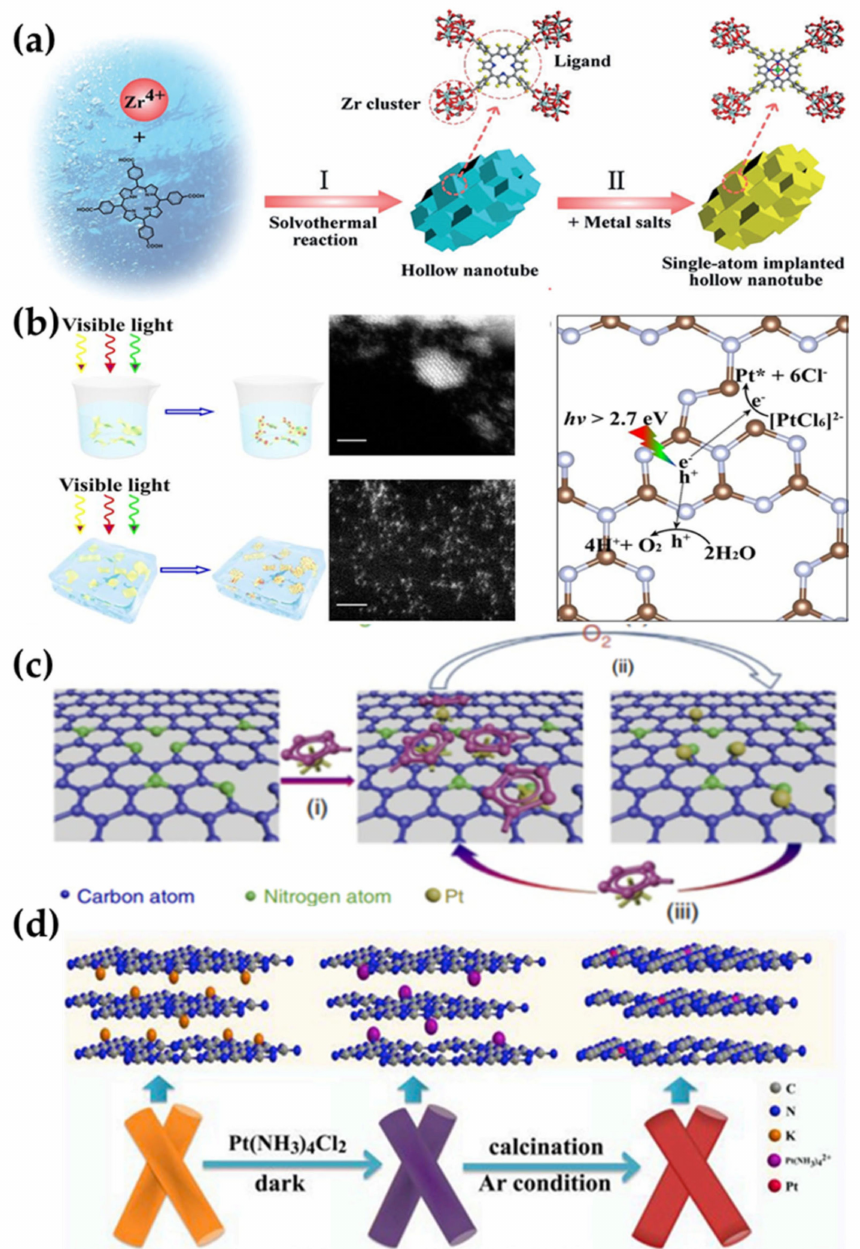
Figure 11. ( a ) Formation of the hollow nanotube MOF and the single atom-immobilized hollow nanotube MOF, which are denoted as HNTM and HNTM-M, respectively [121]; ( b ) Schematic illustration of the icing-assisted in-situ photocatalytic reduction method for preparing the supra- high-density PtSAs-loaded g-C 3 N 4 . Scale bar: 2 nm [129]; ( c ) Schematic illustration of the ALD mechanism for creating Pt single atoms on NGNs [134]; and ( d ) Illustration of the synthetic process of single-atom Pt photocatalysts